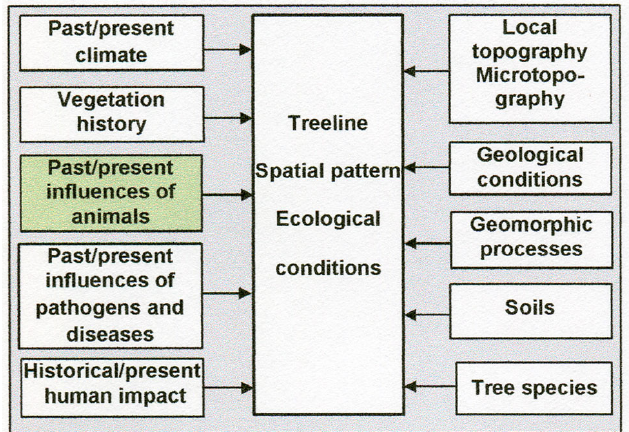
Figure 1: Factors influencing treeline spatial pattern, physiognomy and ecological conditions (modified from Holtmeier